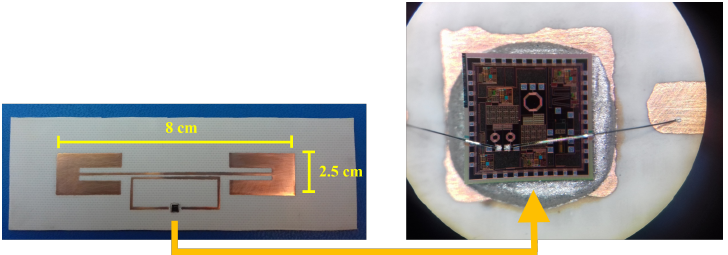
Figure 29. Fully assembled proposed self-powered temperature